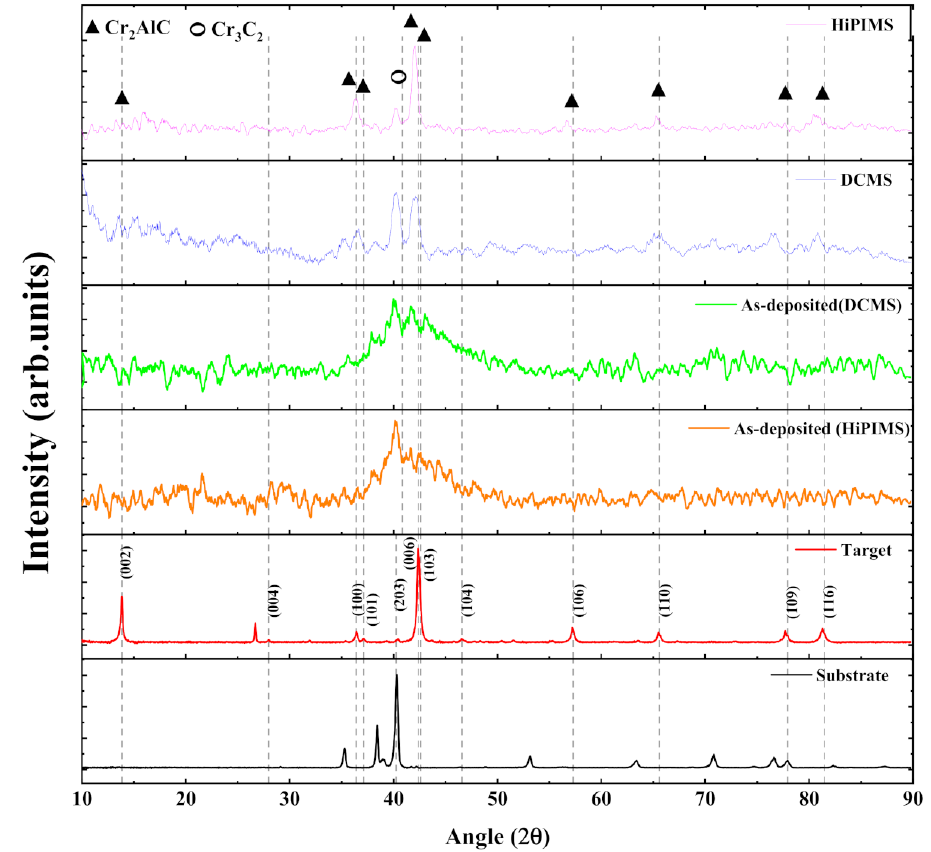
Figure 3. Grazing incidence X-ray diffraction (GIXRD) patterns for the coatings as-deposited and annealed coatings by dc magnetron sputtering (DCMS) (P ave = 112 W) and HiPIMS (P ave = 110